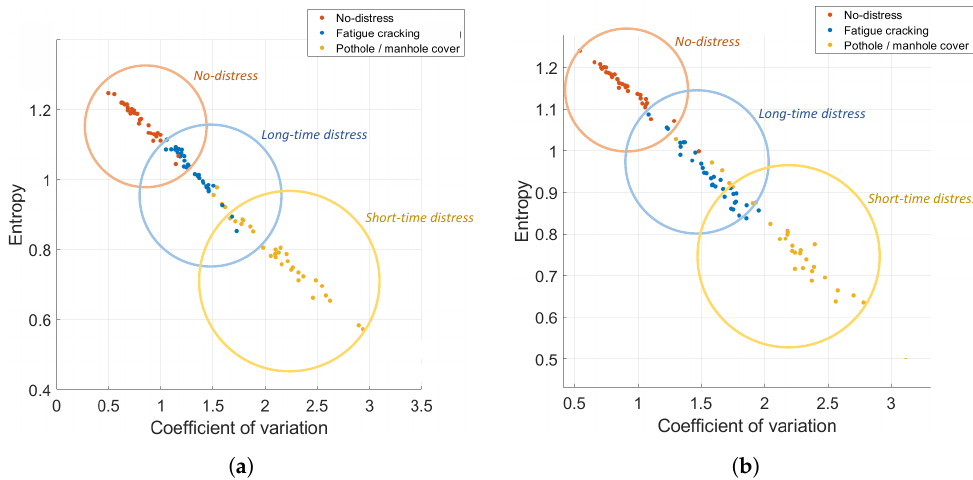
Figure 9. Distribution in the feature space of the data collected on the car’s dashboard ( a ) and floorboard ( b ).